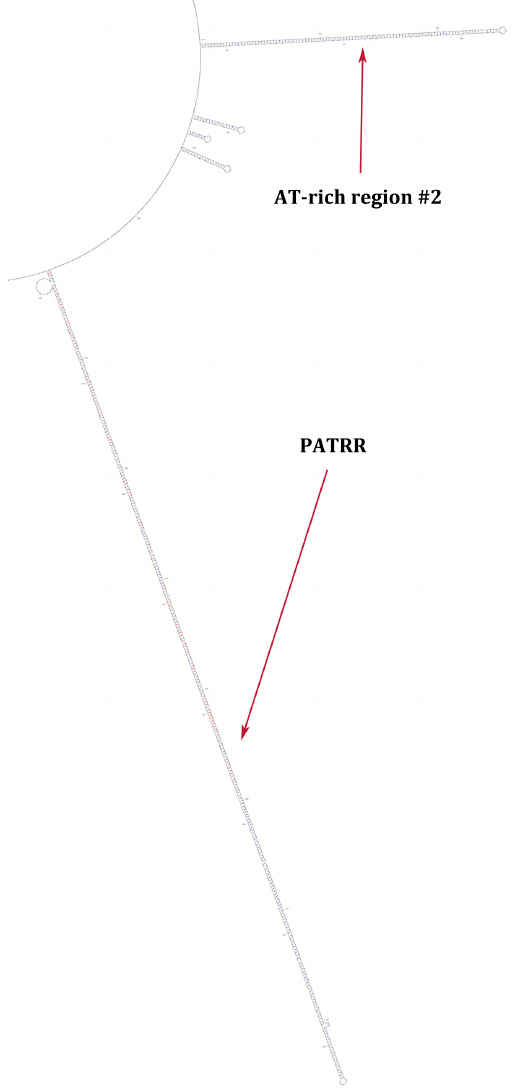
Figure 2. A segment of the secondary structural model of the TBTA (GenBank sequence ID: AB261997.1) showing two long stem loops: the 294 bp palindromic AT-rich repeat sequences (PATRR) and the 104 bp stem loop formed by AT sequences from AT-rich region #2. The PATRR has a significant number of G:C bonds in the lower portion of the stem but is A:T base pair rich in the upper portion close to the loop side. The AT-rich region #2 stem loop consists entirely of A:T bonds with the exception of two G:T bonds. The Zuker DNA folding program [37] was used to generate the secondary structure.